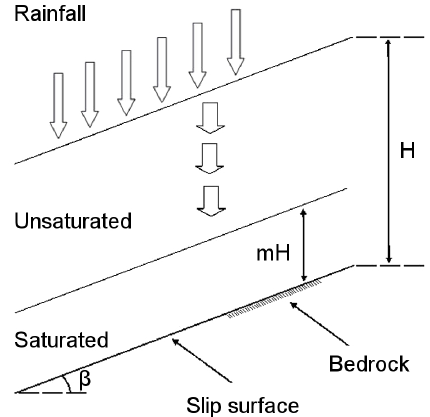
Fig. 3. Diagram of the infinite